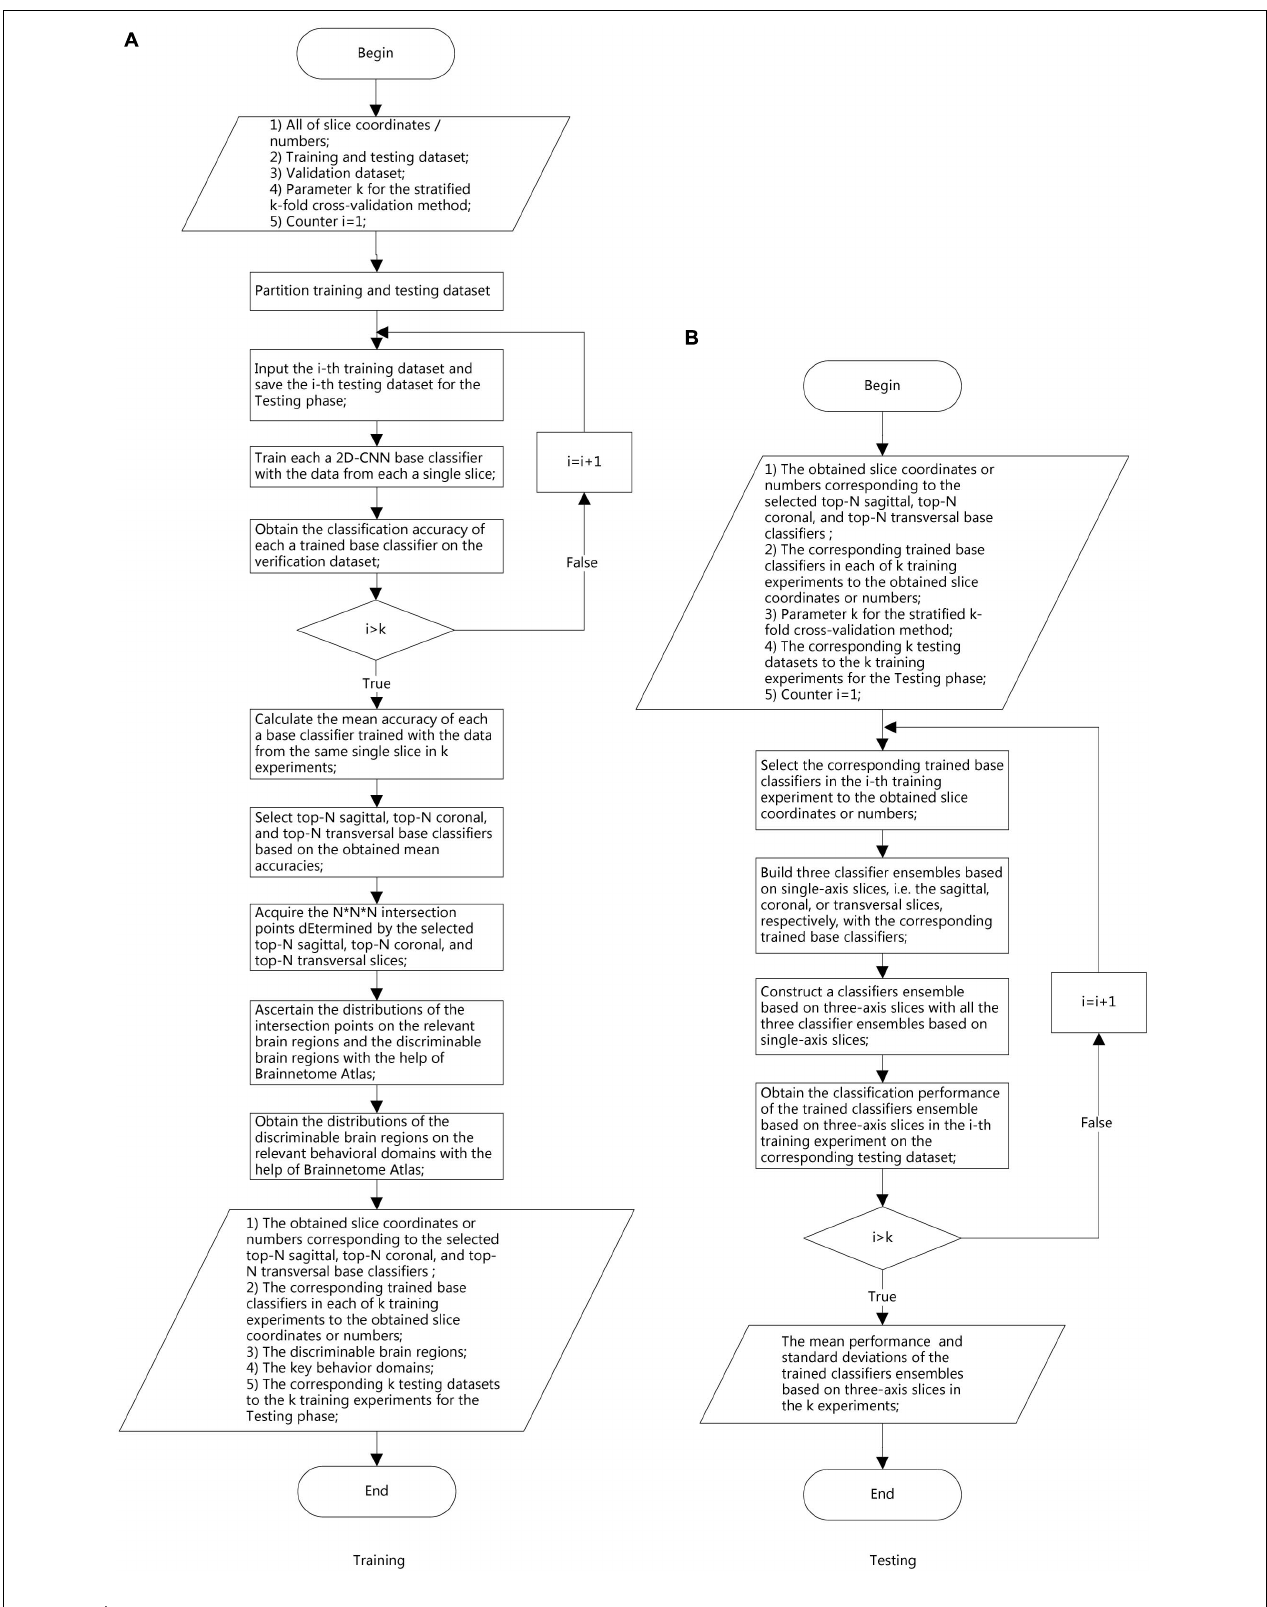
FIGURE 5 | Experimental flow chart. (A) Training phase. (B) Testing